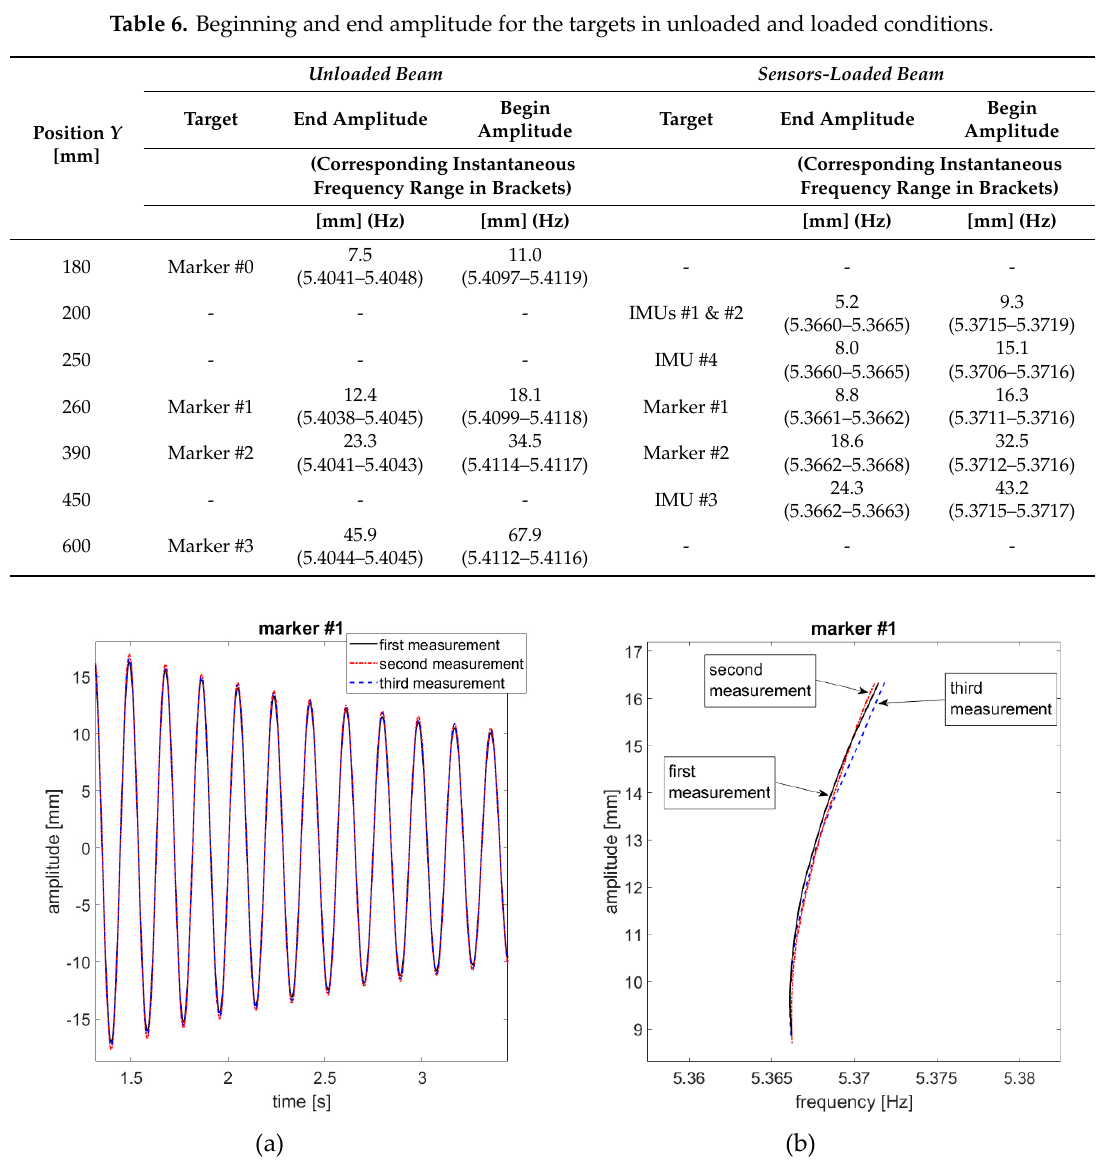
Figure 13. Example of three measured time histories ( a ) and the three backbone curves ( b ) extracted from them. Sensor-loaded conditions, marker #1, acquired at 500 fps.